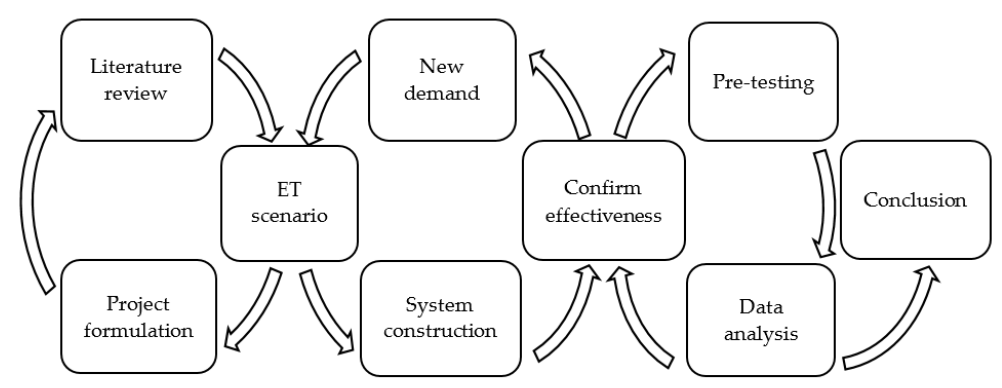
Figure 1. The research flow of the virtual reality-based exposure therapy (VRET) system design and